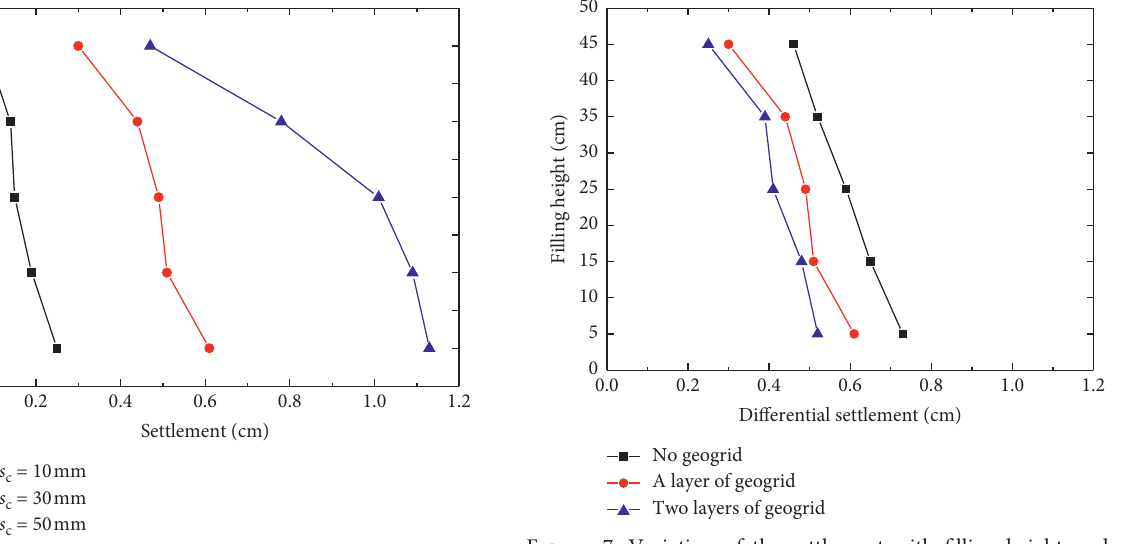
Figure 5: Variation of the settlement with filling height under different consolidation settlement conditions.